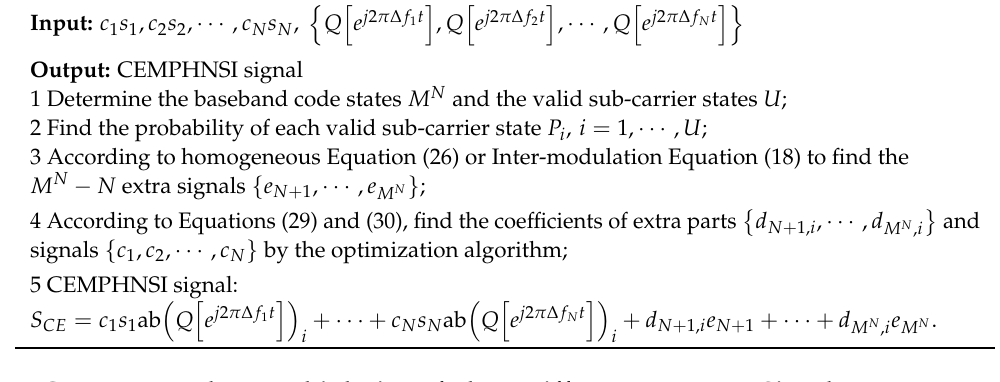
Algorithm 2: Construction based on probability and homogeneous equations without sub-carrier